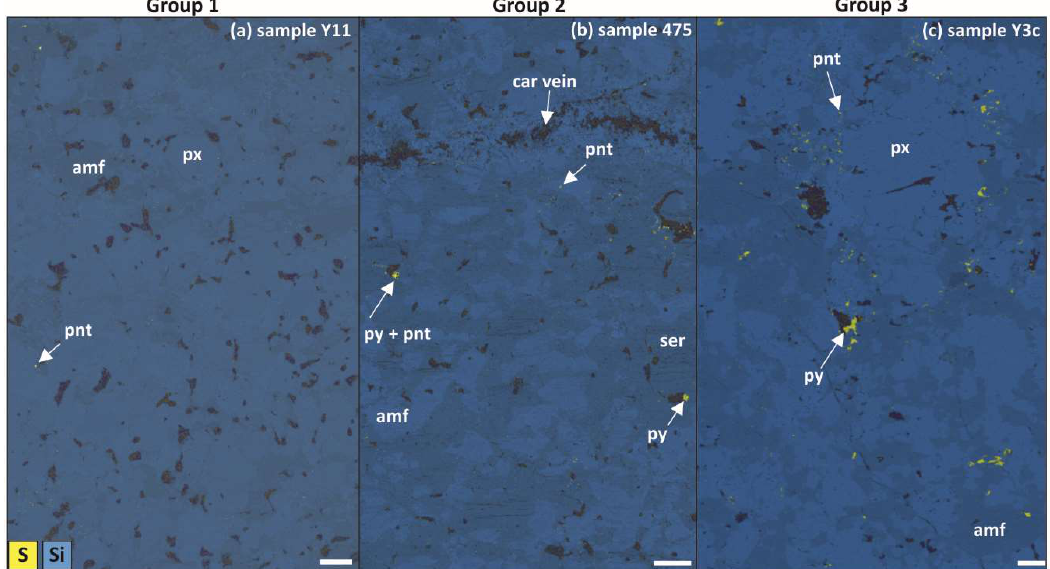
Figure 9. Element maps detailing the mineralogical and textural associations of the sulphide minerals. Note: black areas represent both oxide and carbonate mineral phases. White scale bar = 1